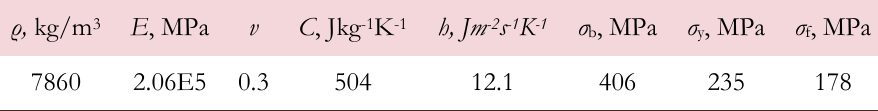
Table 1: Physical and mechanical properties of Q235